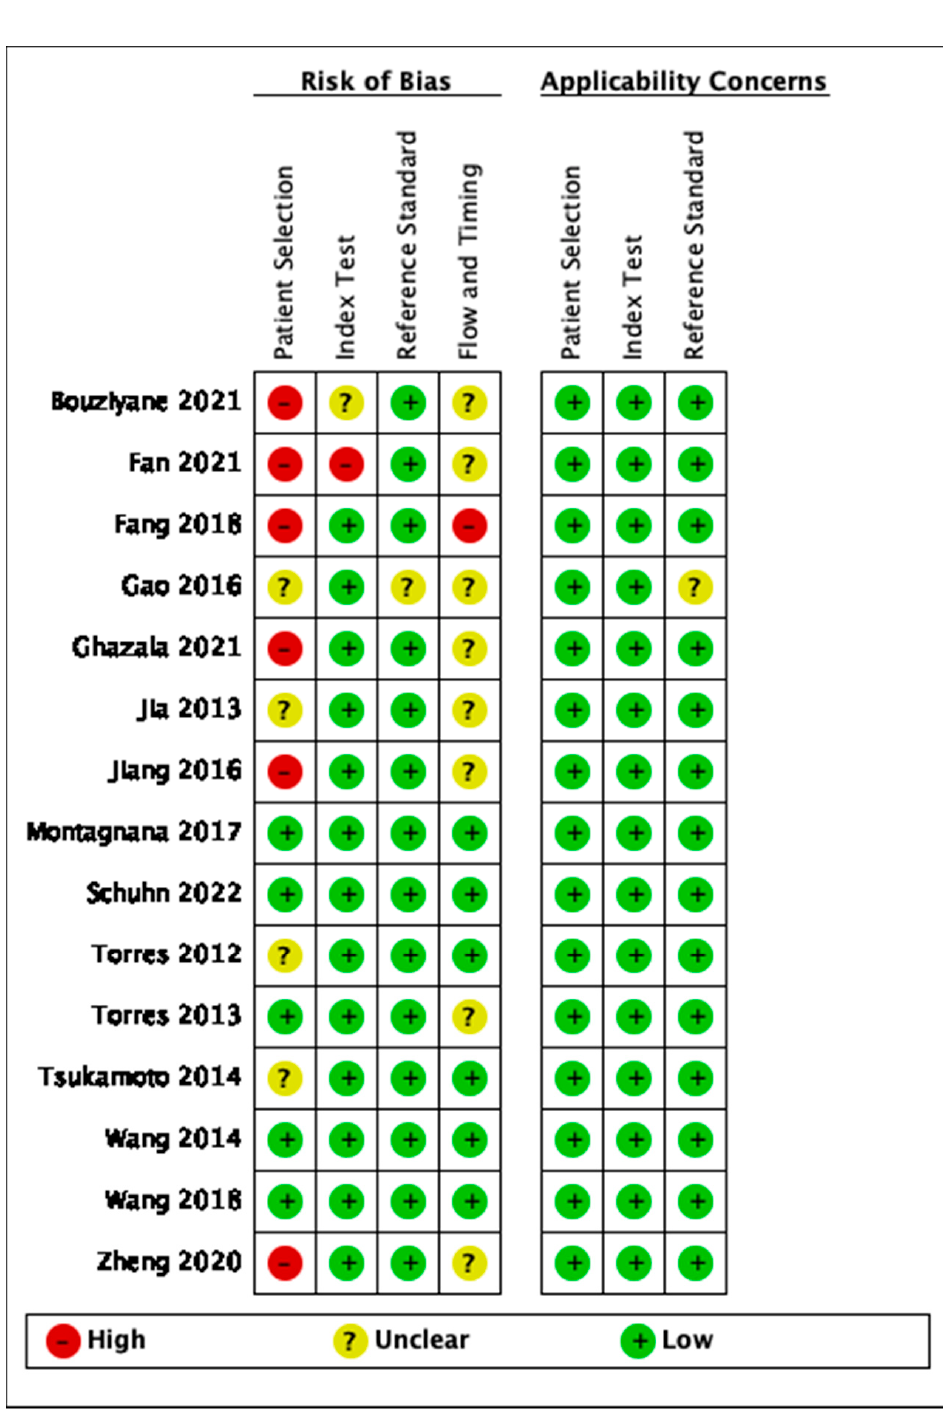
Figure 2. Risk of bias and applicability concerns summary: review authors’ judgements about each domain for exosomal studies.